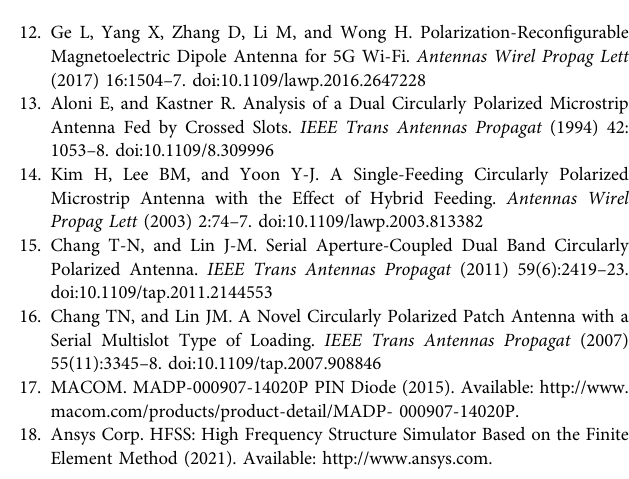
reported polarization recon fi gurable antennas. Compared with pro fi le with three different polarization